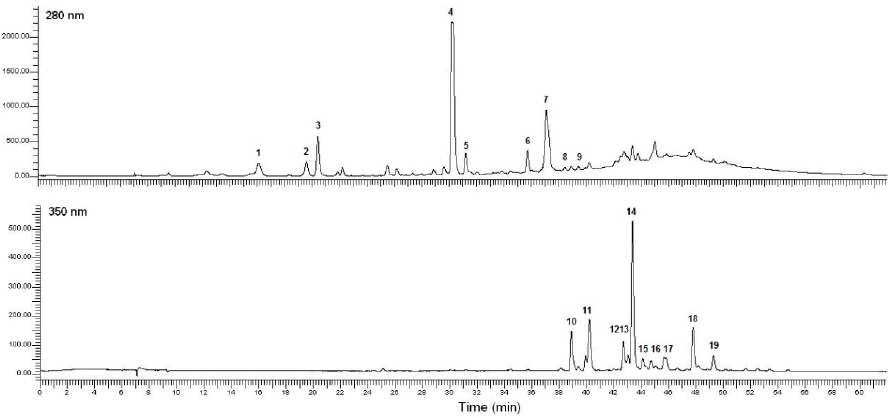
Figure 3. Chromatograms of P. lentiscus leaf extracts obtained using the extraction conditions of trial 9 (BBD, Table 2) acquired at 280 nm (above) and 350 nm (below).